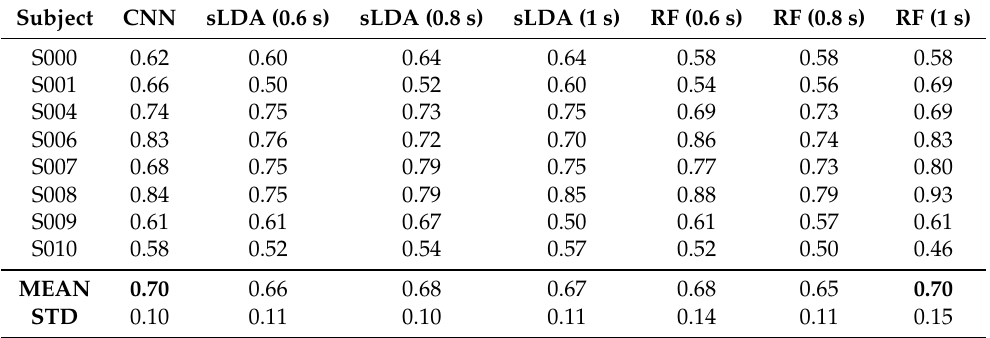
Table A1. Comparison of classification performance (in terms of precision) in validation from Dataset 1 .